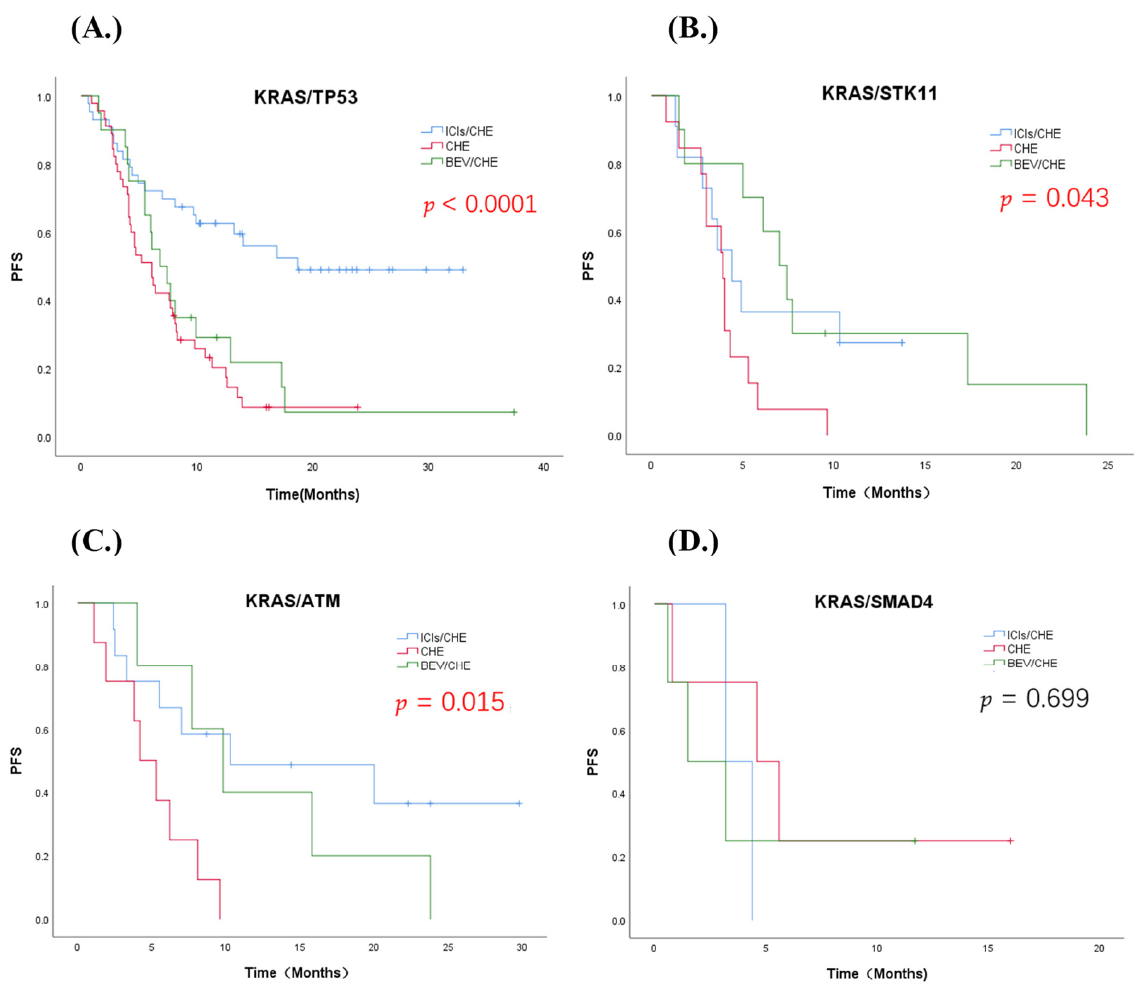
Figure 5. Kaplan–Meier PFS curve of three treatment groups in KRAS-co-mutation classification ( p < 0.05, statistical significance; p < 0.001, significant statistical significance, red indicates. p ≥ 0.05, no statistical significance, black indicates); ( A ) KRAS/TP53; ( B )KRAS/STK11; ( C ) KRAS/ATM; ( D ) KRAS/SMAD4.